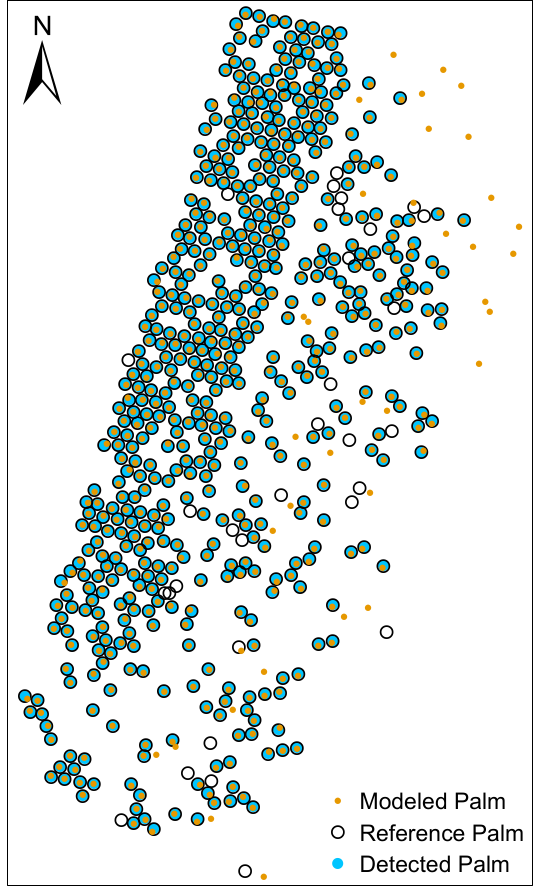
Figure 3: Mapped distribution of reference palms and detection results (100m data